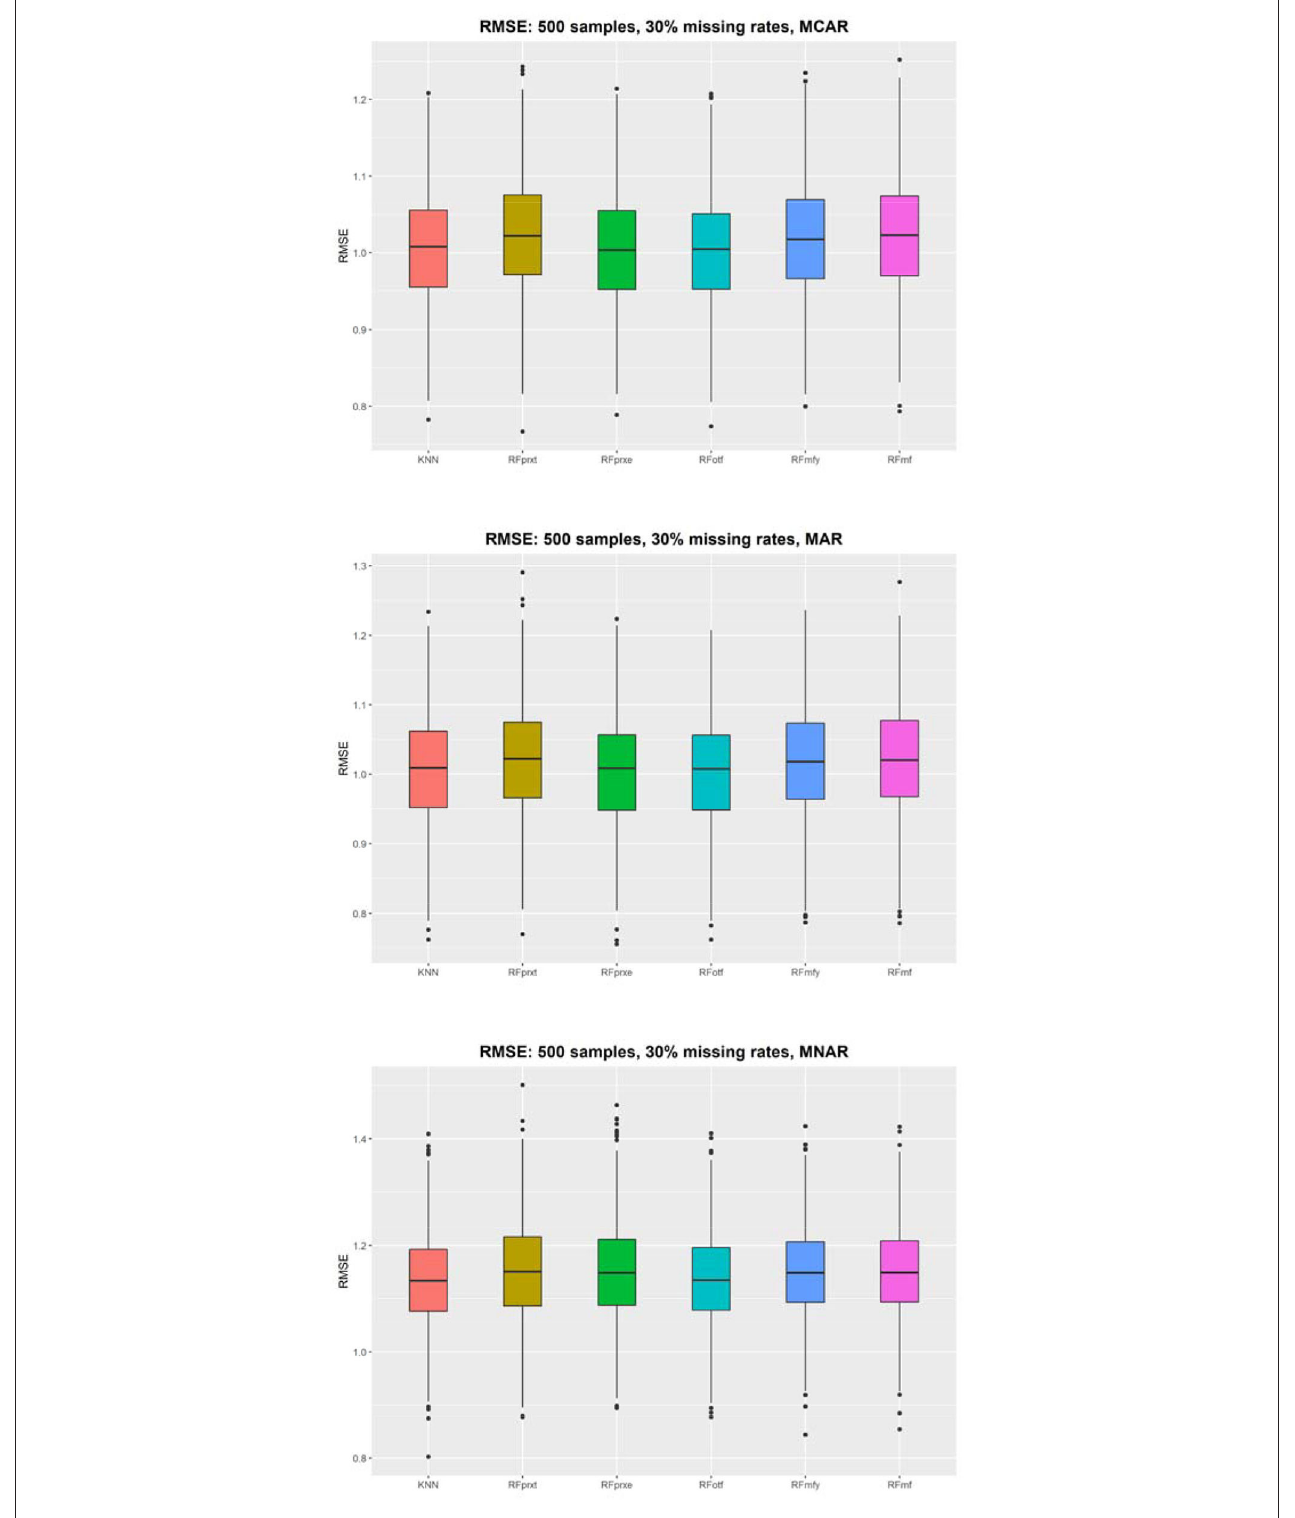
FIGURE 2 | The root means square error (RMSE) using 500 subjects.